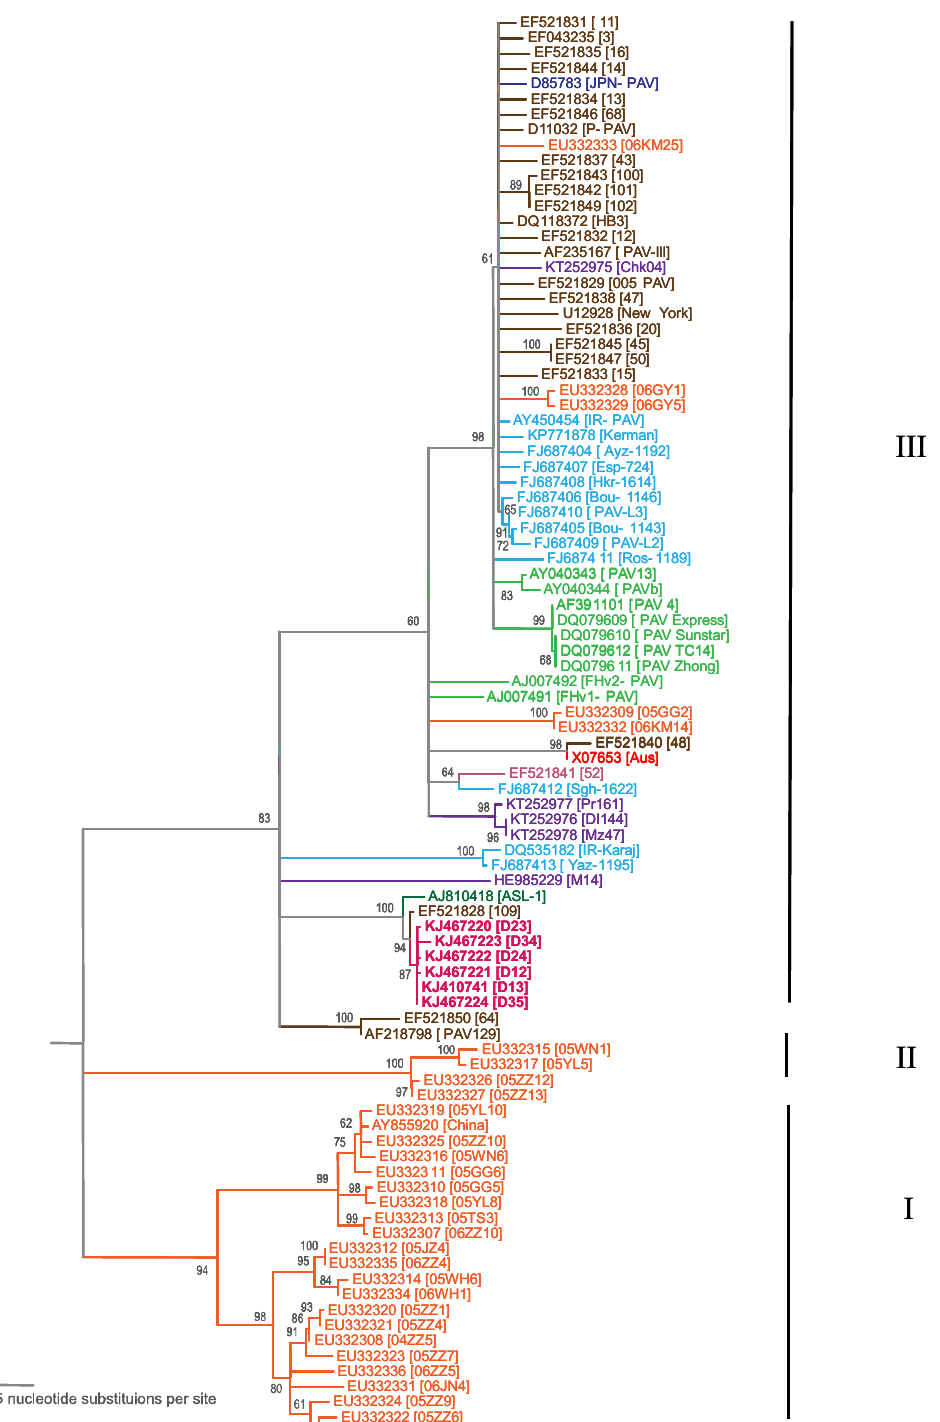
Figure 3. Maximum likelihood phylogenetic analysis of BYDV-PAV isolates. Taxa and branches are coloured based on sampling